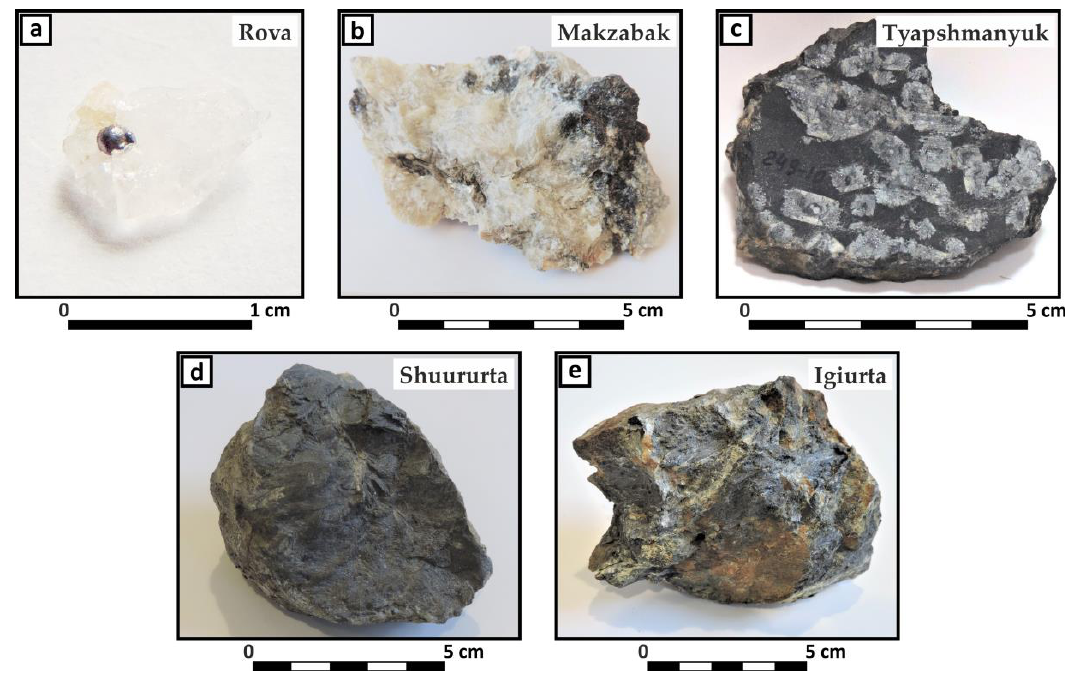
Figure 2. Studied carbonaceous matter (CM)-bearing rocks: ( a ) Quartzolite from the Keivy alkaline granite complex (the Rova area), ( b ) sillimanite schist, selected near the contact with this complex (the Makzabak area), and kyanite schists from ( c ) the Tyapshmanyuk, ( d ) the Shuururta and ( e ) the Igiurta areas.